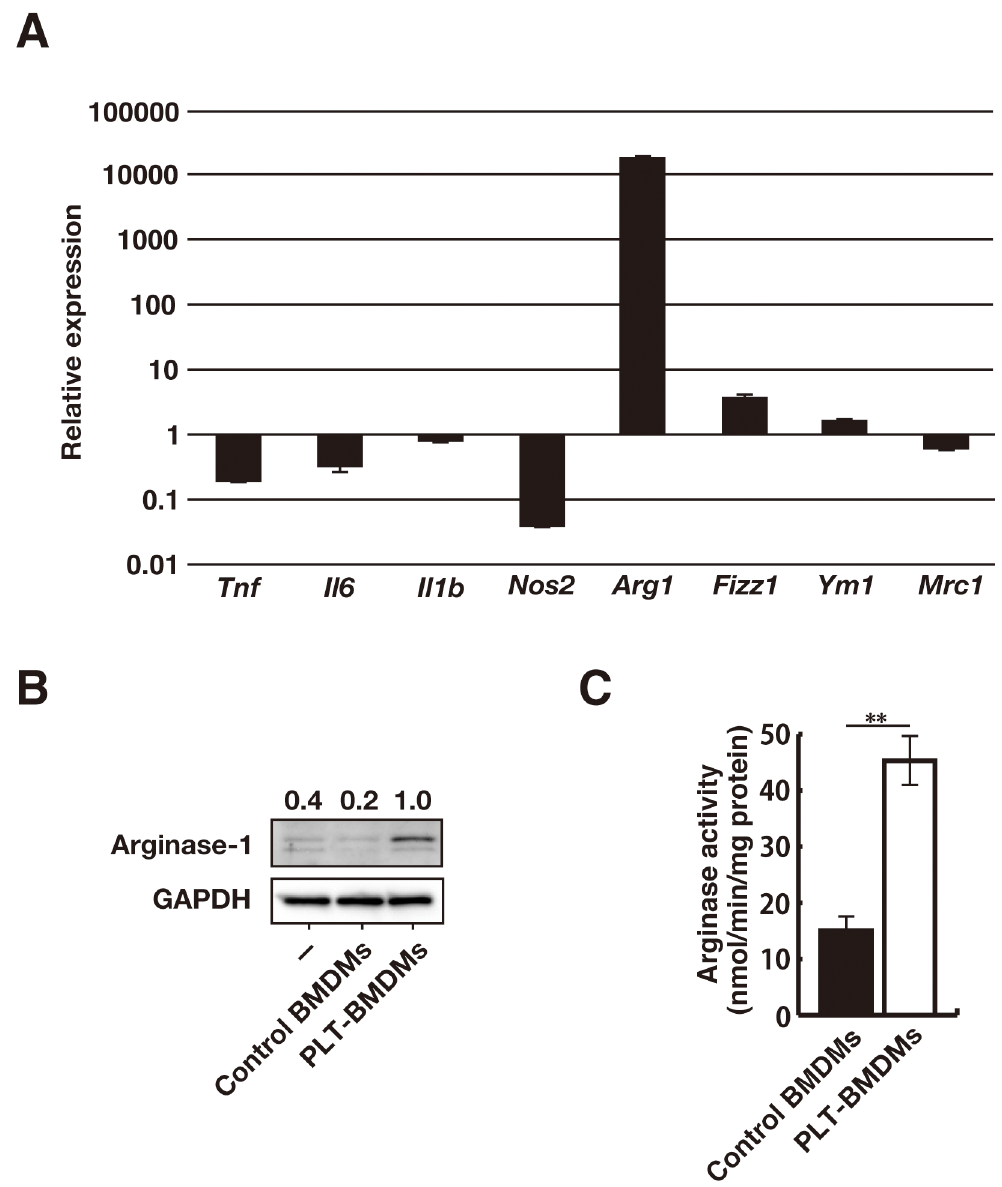
Fig 3. Induction of arginase-1 expression by PLT-sup in BMDMs. (A) The gene expressions of Tnf , Il6 , Il1b , Nos2 , Arg1 , Fizz1 , Ym1 , and Mrc1 in PLT-BMDMs and control BMDMs were analyzed by RT-qPCR with the relative standard curve method using Gapdh as an internal control. The gene expression in PLT-BMDMs was represented as the value relative to gene expression in control BMDMs. Experiments were performed in triplicate and repeated three times. Data are presented as the mean ± SEM, and representative results of the three experiments are shown. (B) PLT-BMDMs and control BMDMs were lysed in 1 × SDS sample buffer, and the resultant lysates were subjected to western blotting analysis with antibodies against arginase-1 or GAPDH. The relative intensity of each arginase-1 band after normalization to the corresponding levels of GAPDH is shown above each blot. Experiments were repeated five times, and representative results are shown. (C) PLT-BMDMs and control BMDMs (4 × 10 5 cells) were lysed with 0.1% Triton X-100 (100 μ L) containing a protease inhibitor cocktail for 10 min at room temperature, and the lysate was assayed for arginase activity as described in the Materials and Methods. Experiments were performed in quintuplicate and repeated five times. Data are presented as the mean ± SEM. ** p < 0.01 vs. control BMDMs. Representative results of the five experiments are shown.